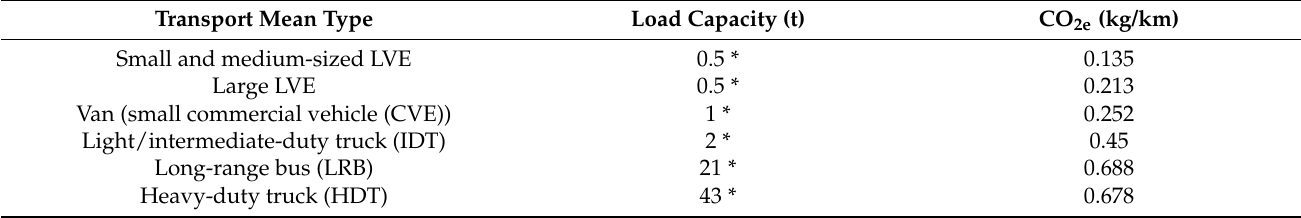
Table 7. Road transport used for short and intermediate distance trips for goods and staff transportation [46–48].